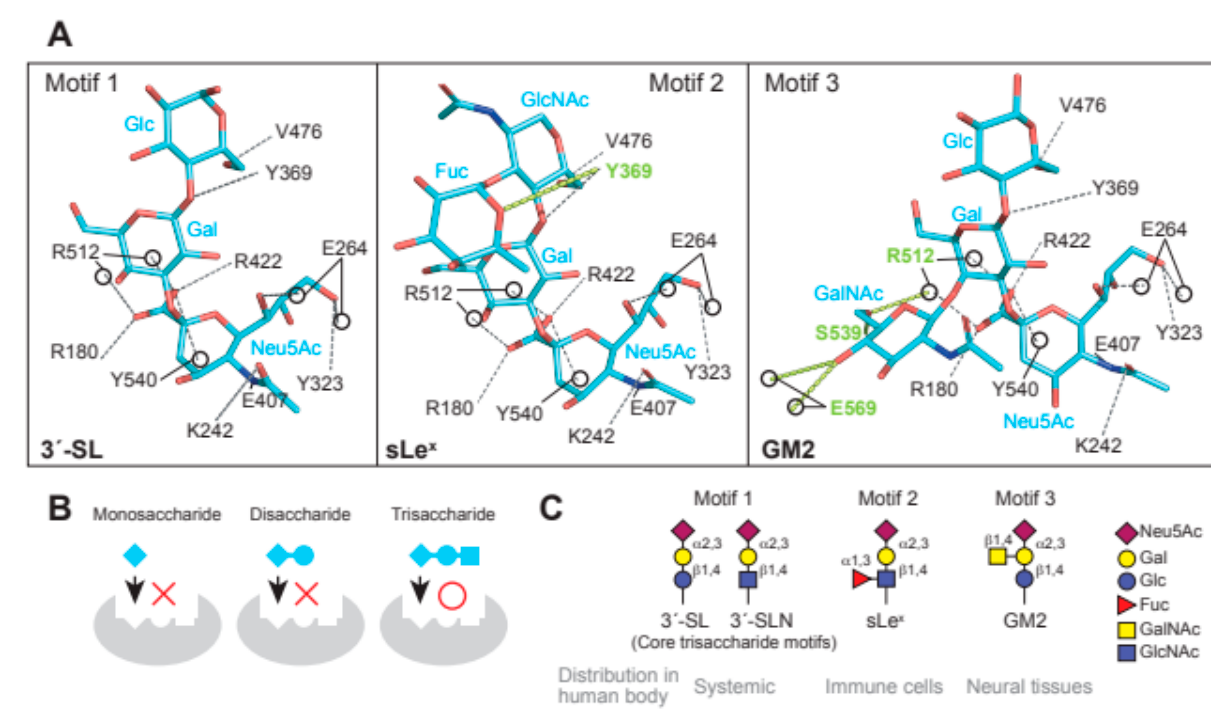
Figure 2. Glycan receptors with trisaccharide cores for MuV. ( A ) Interaction of the three receptor glycan motifs, 3 ′ -SL (motif 1), sLe x (motif 2), and GM2 (motif 3), with the amino acid residues of MuV-HN. The interactions between MuV-HN and the core trisaccharide moieties of 3 ′ -SL (Neu5Ac α 2,3Gal β 1,4Glc), sLe x (Neu5Ac α 2,3Gal β 1,4GlcNAc), and GM2 (Neu5Ac α 2,3Gal β 1,4Glc) are completely conserved; ( B ) The sialyl-trisaccharide exhibits a higher affinity for MuV-HN compared to that of the sialyl-disaccharide. The trisaccharide structure is a necessary core-receptor structure for MuV; ( C ) Schematics of the three receptor motifs and their distributions in the human body.